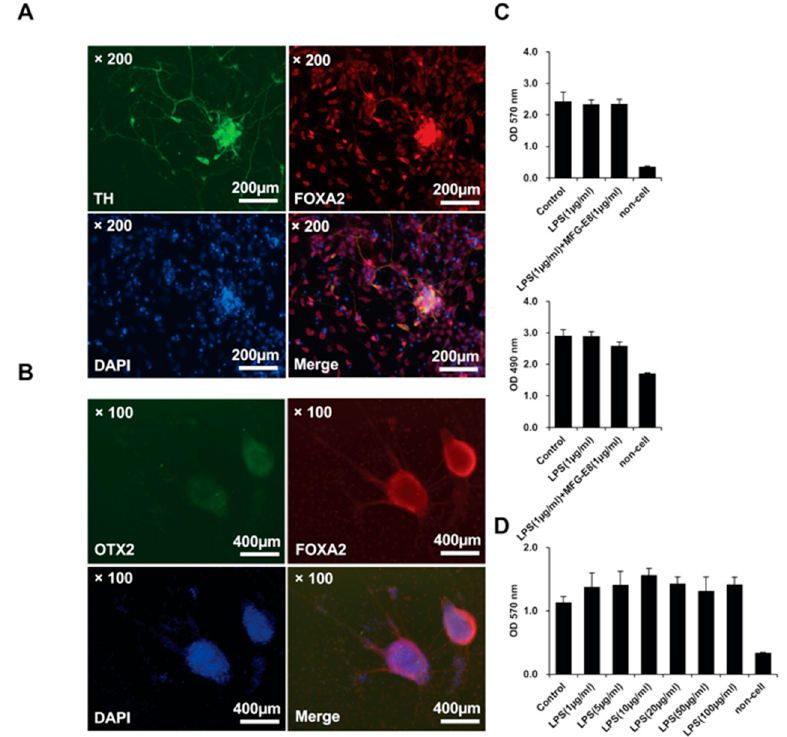
Figure 5. The effect of LPS and human MFG-E8 on the viability of iPSC-derived dopamine neurons. Immunohistochemical staining of TH (top, left panel) and FOXA2 (top, right panel) on iPSC-derived dopamine neurons. The lower panels show 4 (cid:48) 6-diamidino-2-phenylindole (DAPI) staining (bottom, left panel) and a merged image of TH-FOXA2-DAPI staining (bottom, right panel). The images were obtained using an optical microscope. Scale bar = 200 µ m. ( A ) Immunohistochemical staining of OTX2 (top, left panel) and FOXA2 (top, right panel) on iPSC-derived dopamine neurons. The lower panels show DAPI staining (bottom, left panel) and a merged image of OTX2-FOXA2-DAPI staining (bottom, right panel). The images were obtained using an optical microscope. Scale bar = 400 µ m ( B ). Cell viability assays (MTT assay) of iPSC-derived dopamine neurons after 48 h of culture in the presence or absence of 1 µ g/mL LPS and 1 µ g/mL human MFG-E8. Each measurement was performed using a microplate reader. The absorbance values (570 nm) are indicated. n = 4. The data represent the mean ± SD ( C , top panel). Cytotoxicity assays (LDH assay) of iPSC-derived dopamine neurons after 48 h of culture in the presence or absence of LPS (1 µ g/mL) and MFG-E8 (1 µ g/mL). Each measurement was performed using a microplate reader. The absorbance values (490 nm) are indicated. n = 4. The data represent the mean ± SD ( C , lower panel). Cell viability assays (MTT assay) of iPSC-derived dopamine neurons after 48 h of culture in the presence or absence of 1, 5, 10, 20, 50, and 100 µ g/mL LPS. Each measurement was performed using a microplate reader. The absorbance values (570 nm) are indicated. n = 4. The data represent the mean ± SD ( D